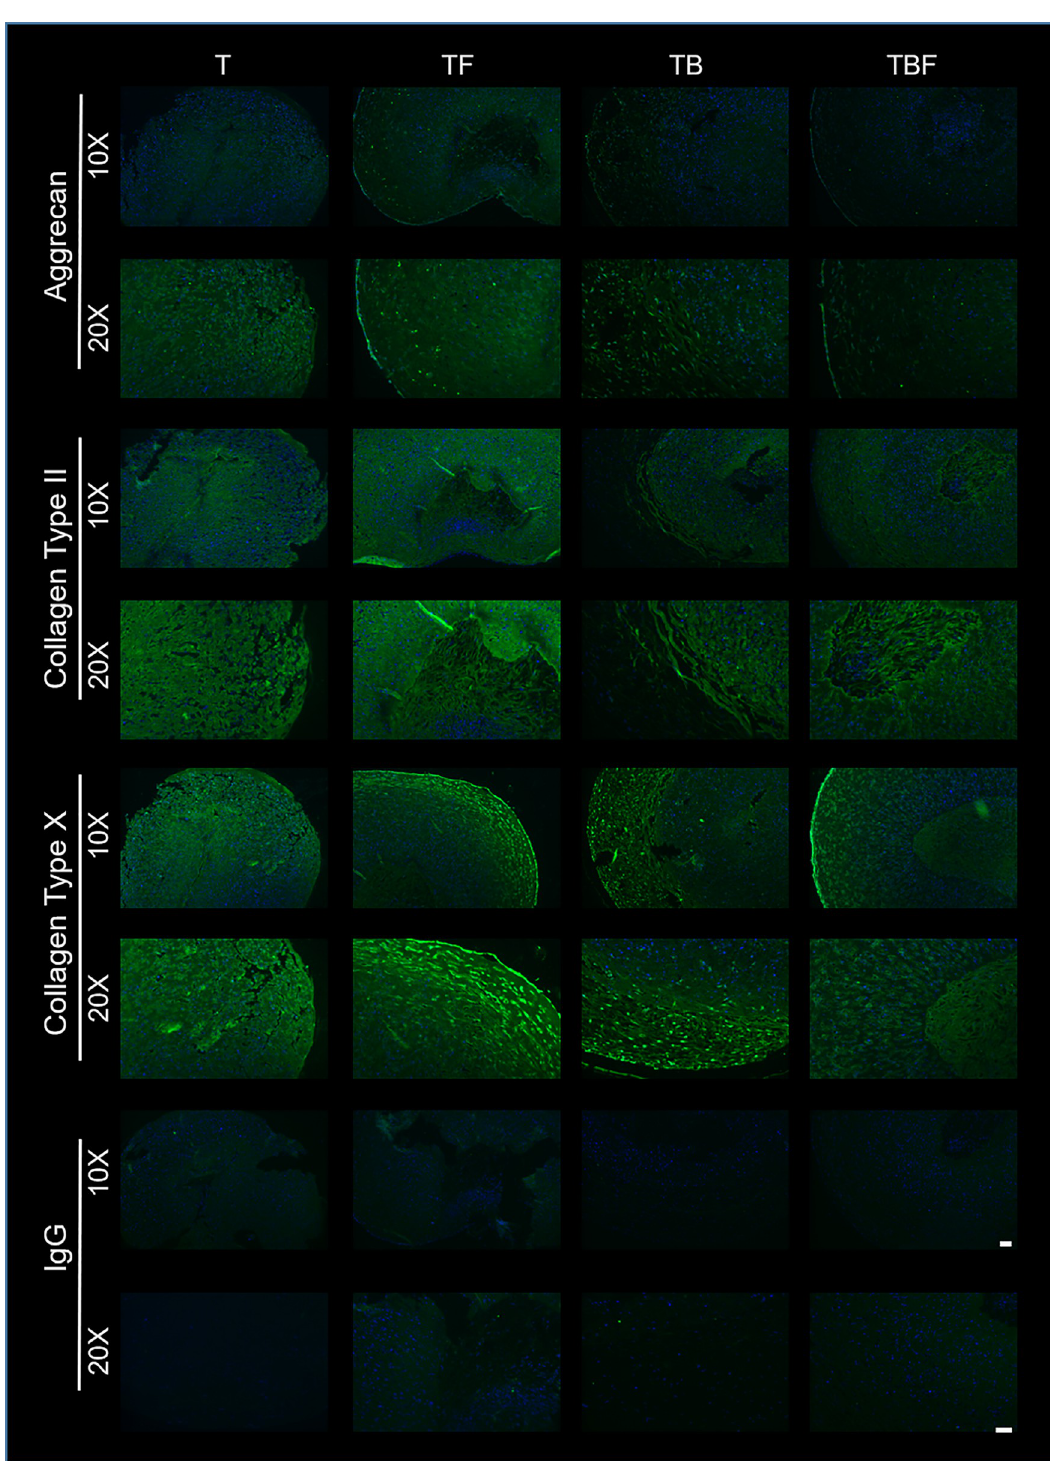
Fig 9. Immunofluorescence of select extracellular matrix (ECM) components. Matched sections from traditional histology (Fig 8) were assessed via immunofluorescence for aggrecan, Collagen Type II, and Collagen Type X. Primary antibodies were detected via a goat-anti-rabbit Alexafluor 488 secondary and nuclear staining was accomplished using DAPI. Negative control sections (IgG) were incubated with normal rabbit IgG prior to staining with Alexafluor 488-labelled secondary and DAPI. Aggrecan, Collagen Type II, and Collagen Type X were detected in all treatment groups. Aggrecan was detected more diffusely in groups T and TF, whereas in